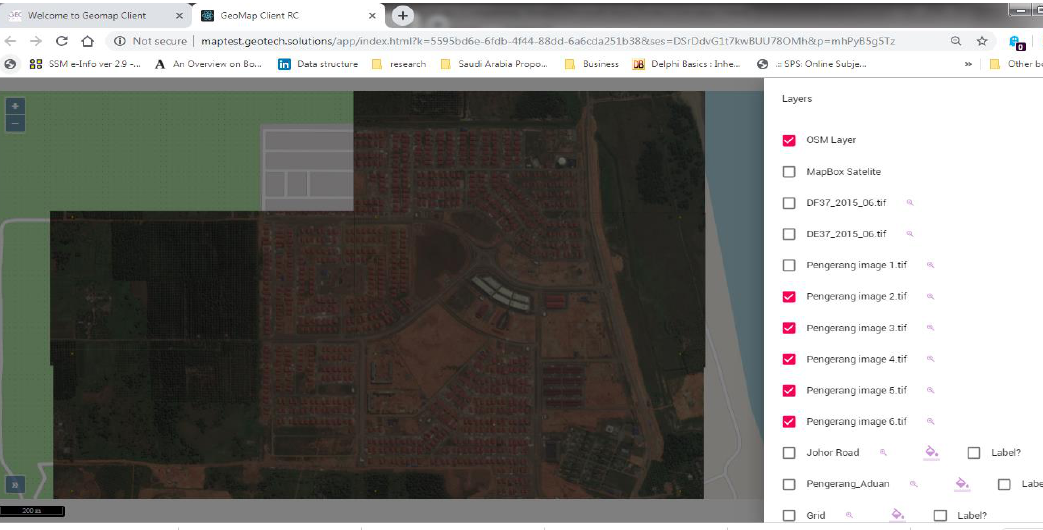
Figure 21: Example of GeoMap client viewer for shared imagery (e.g. from UAV drone) for other stakeholders and developer/applicant